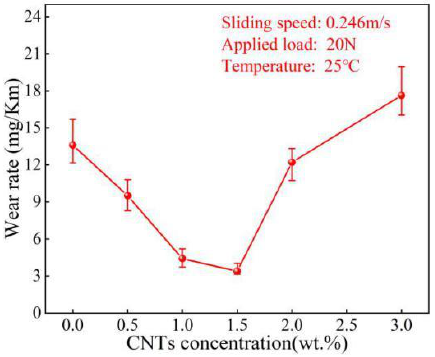
Figure 11. Wear rate versus CNT wt%.